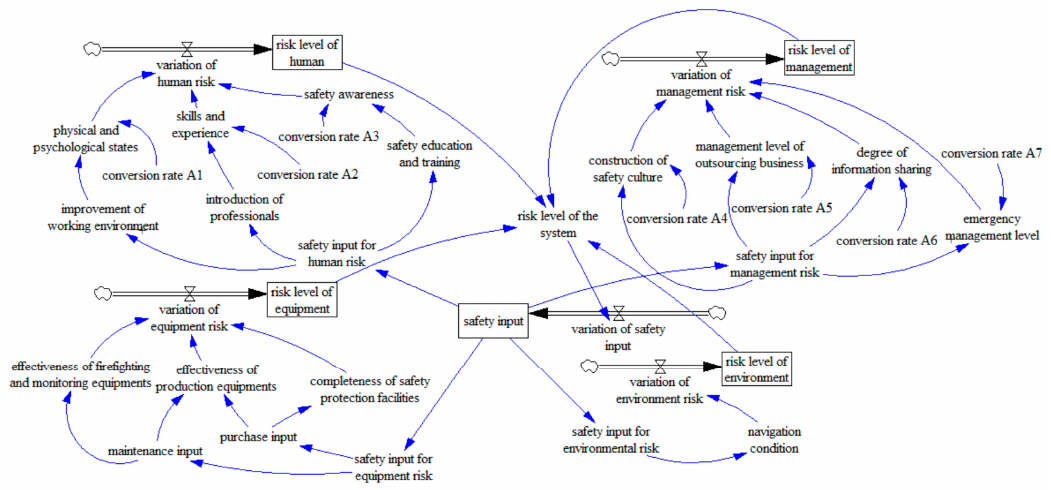
Figure 3. Flowchart of the system.